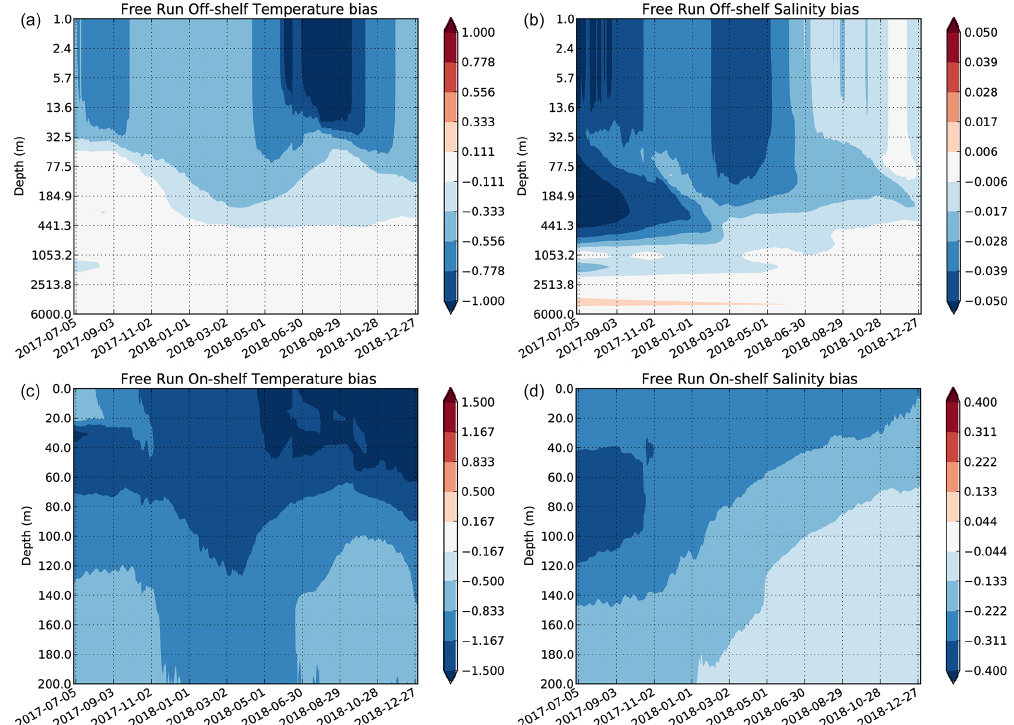
Figure 3. Free run temperature (a,c) and salinity (b,d) biases relative to the nature run (free – nature) for the off-shelf (a,b) and on-shelf (c,d) regions. Note that the off-shelf plots are shown on a log depth